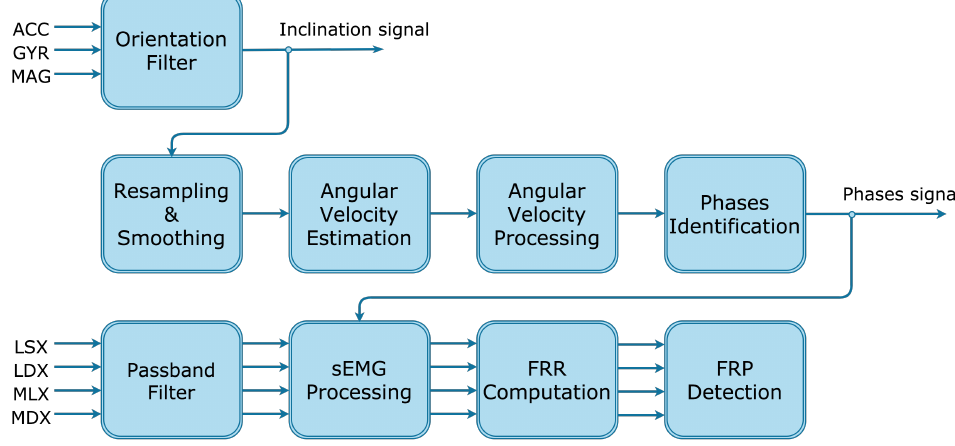
Figure 3. Block diagram of the proposed algorithm for clinical assessment of the